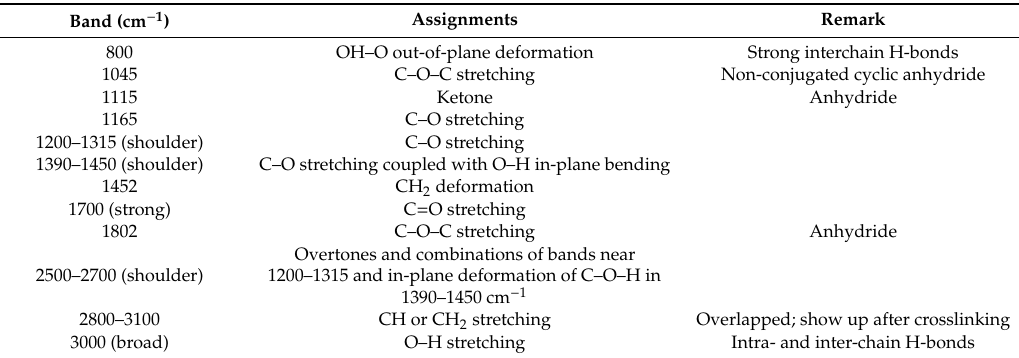
Figure 6. Fourier transform infrared spectra of ( a ) as-spun PAA and ( b ) XLPAA NFs for various electrospinning voltages. All of the spectra were normalized with the peak intensity of the band at 1452 cm − 1 , which was assigned to the CH 2 deformation. The di ff erence spectra between ( a ) and ( b ) is shown in ( c ), which includes anhydrides, high-energy states (gauche), and low-energy states (trans) at 1802, 1757, and 1698 cm − 1 , respectively, thereby indicating conformational changes from trans to gauche states after crosslinking. Figure ( d ) shows the intensity ratios of peaks at 1757 and 1698 cm − 1 in the original spectra, which indicate a substantial increase in gauche states after crosslinking. Also, the inset in ( d ), which magnifies the intensity ratio scale (Y-axis) according to those of the as-spun PAA NFs, shows that the as-spun PAA NFs at 14 kV had the highest relative quantity of trans states. Table 1. Band assignment in IR spectra of